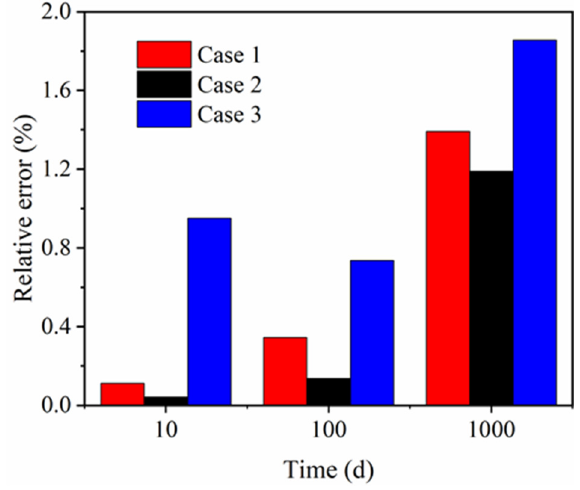
Figure 6. Relative error between the values predicted by the LSTM networks and the true values under different production times.